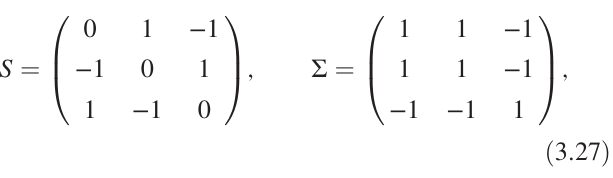
FIG. 17. Symmetry-preserving many-body gapping interaction. represents a chiral Pfaffian channel into or out of paper. The purple dashed line represents many-body gapping interaction U in (3.47). (b) Coupled-wire model on a single layer along the diagonal